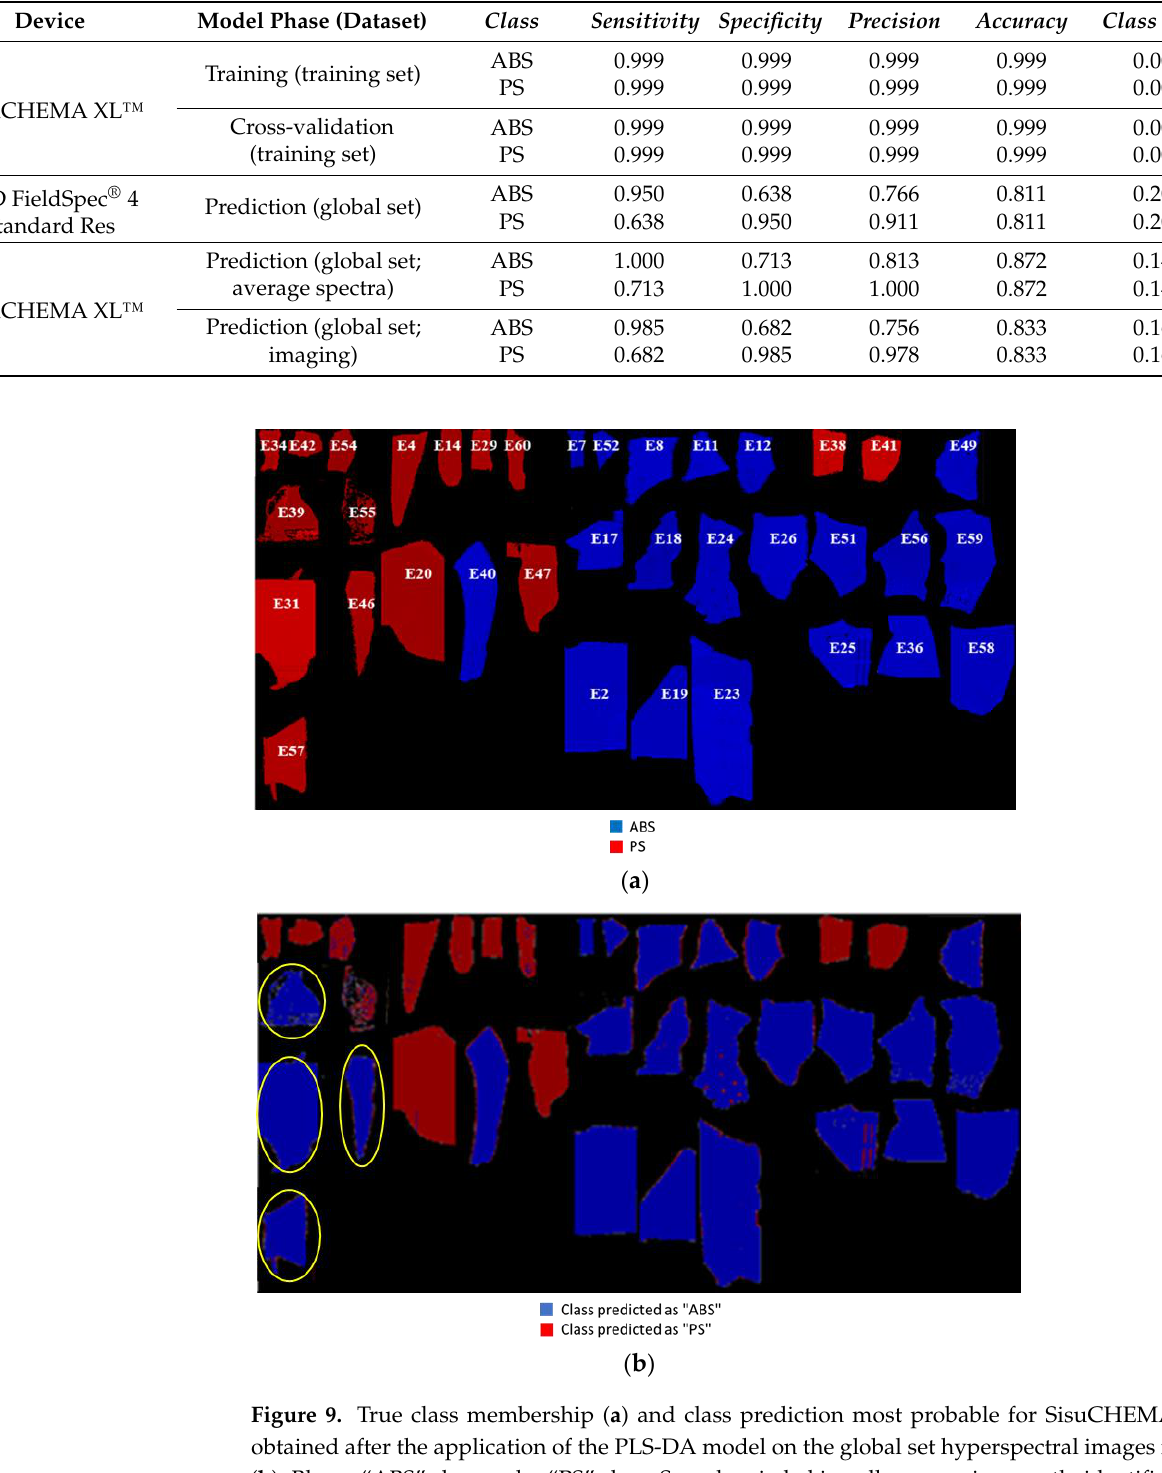
Table 6. Classification performance metrics for polymer identification by using ASD FieldSpec ® 4 Standard-Res and SisuCHEMA XL™ global set data (average spectra and imaging).